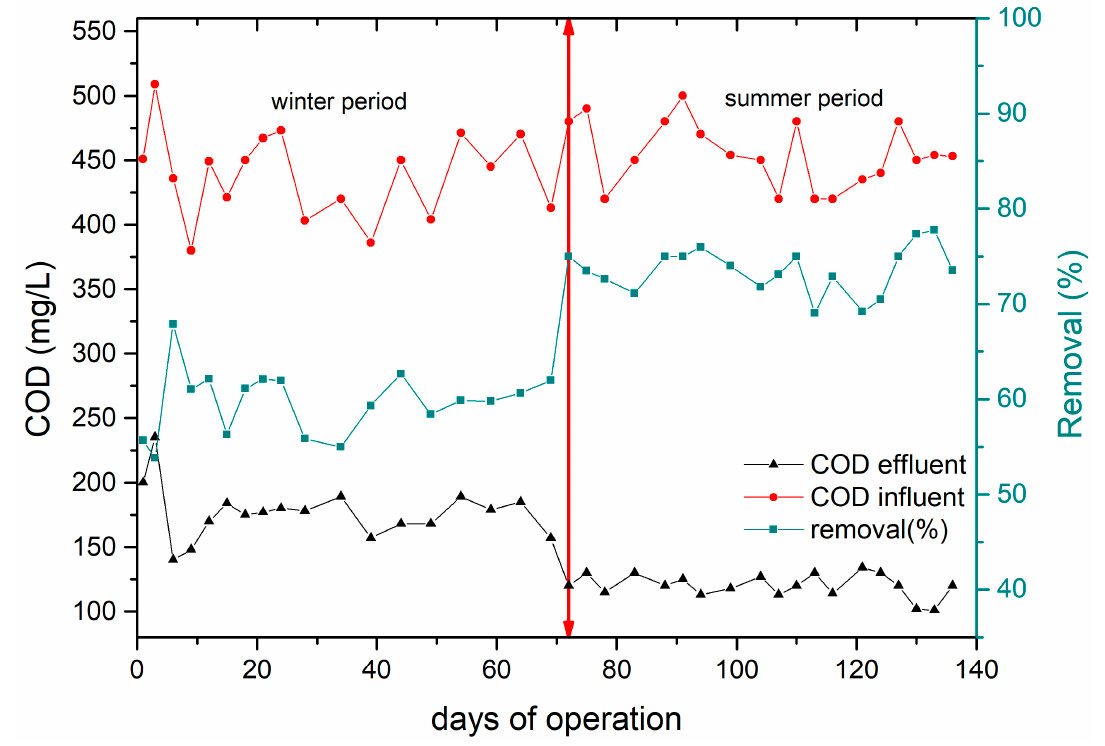
Figure 2. AnMBR performance at 6 h in terms of COD removal.